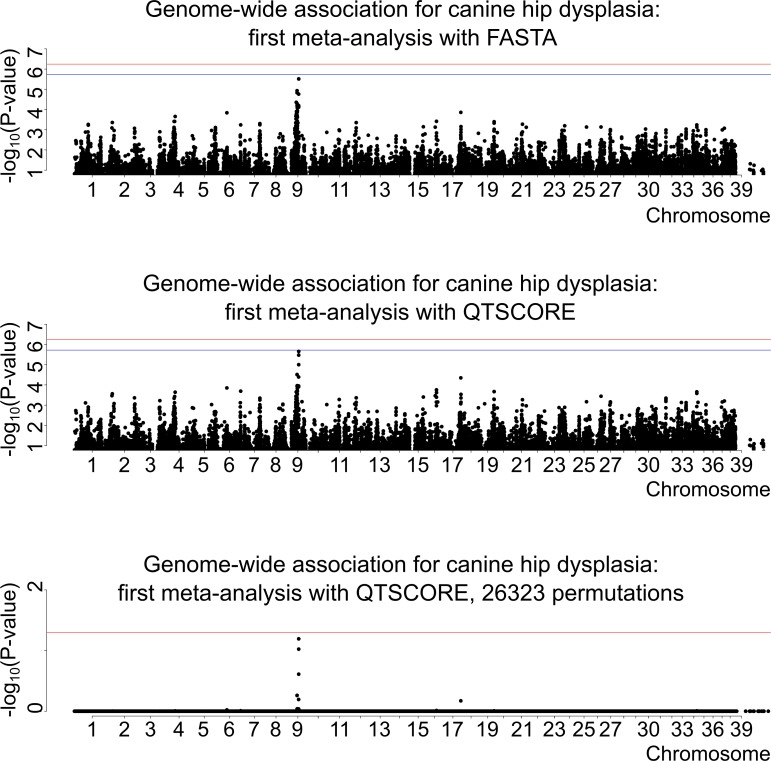
Genome-wide association for canine hip dysplasia: First meta-analysis, N(cases) = 132, N(controls) = 277.For the upper two figure segments the red horizontal line is the threshold for Bonferroni correction for significance. The blue horizontal line is the threshold for significance for independent tests. In the undermost segment, where the permuted P-values are shown, the single red line represents the threshold for genome-wide significance level of 0.05.